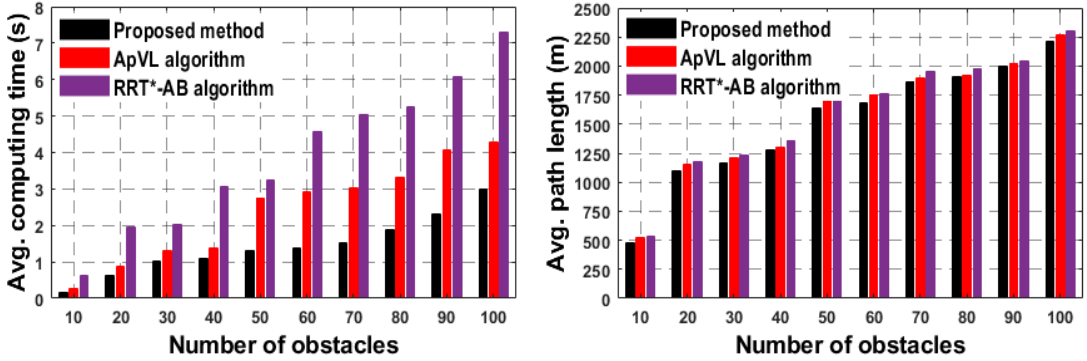
Figure 10. ( Left ) computing time: proposed method versus existing algorithms; ( Right ) path lengths: proposed method versus existing